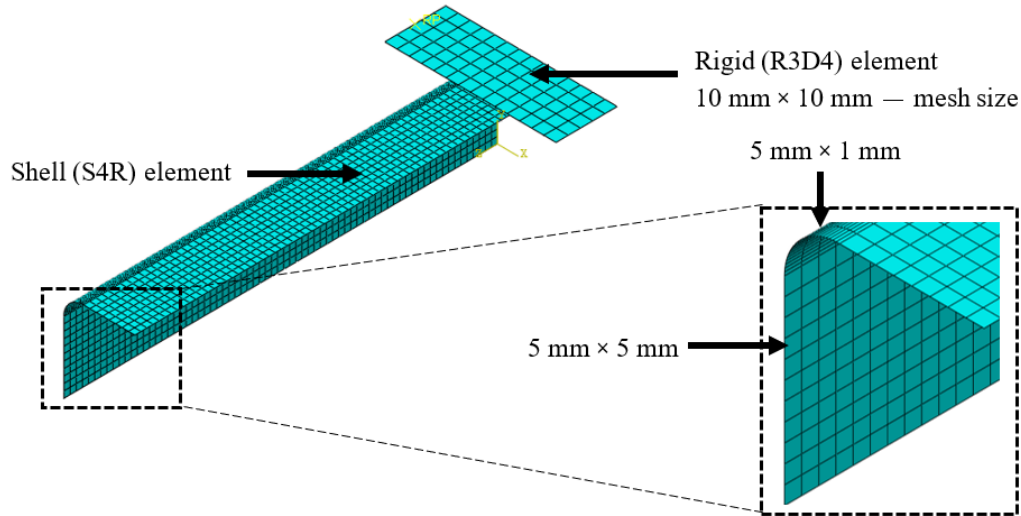
Figure 4. Applied element types and mesh sizes.